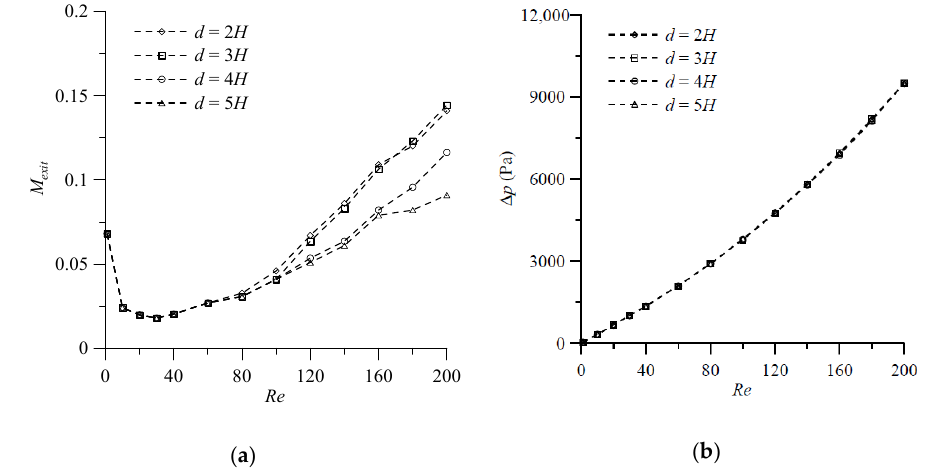
Figure 10. Effect of the distance between the antisymmetric VIOs on ( a ) the degree of mixing, and ( b ) the pressure drop in the mixers with θ a = 30 ◦ , h = 0.75 H , t = 0.25 H and w d = 0.25 H for various Reynolds numbers.